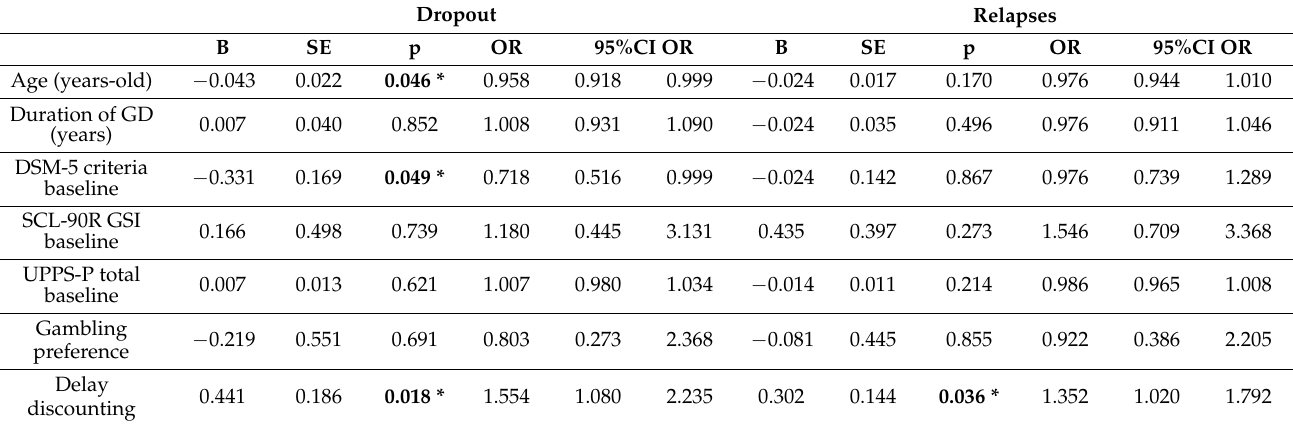
Table 3. Predictive model for the CBT outcomes: logistic